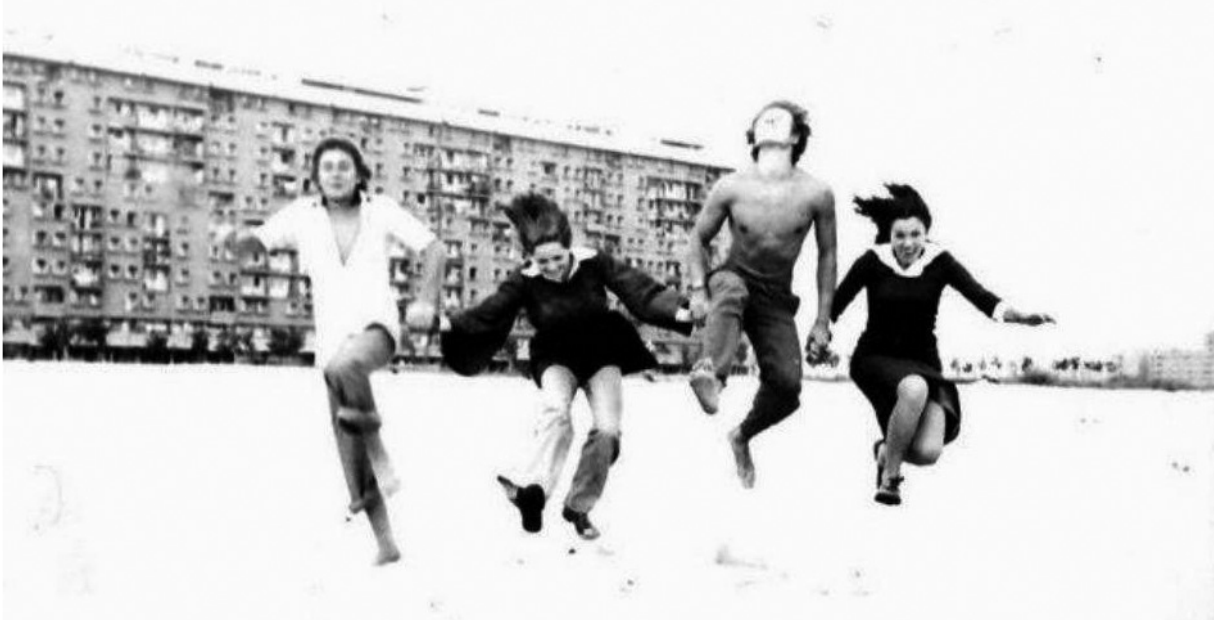
Figure 6. Ilija Arnautovic’s linear building in Block 28, New Belgrade, 1974. Source: Stare slike Novog Beograda (2013; © Photograph by Olivera Sumanac,